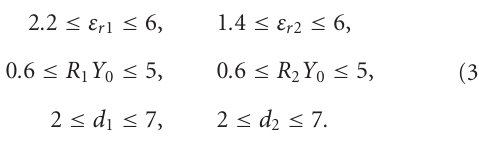
the parallel polarization (dipoles parallel with E -field). As it is seen in Figure 3, we have obtained a high-reflection behavior for the orthogonal polarization over 1–16 GHz. For the parallel polarization, we have obtained a transparent window at and below 1 GHz with less than 10 dB reflection (the structure is lossless). The frequency response then rapidly reaches towards a high-reflection behavior over frequency band between 3 and 15 GHz, with a normal reflection coe ffi cient above − 4 dB. The next step is to integrate the design given in Figure 2 with an absorber, which is the subject of the next